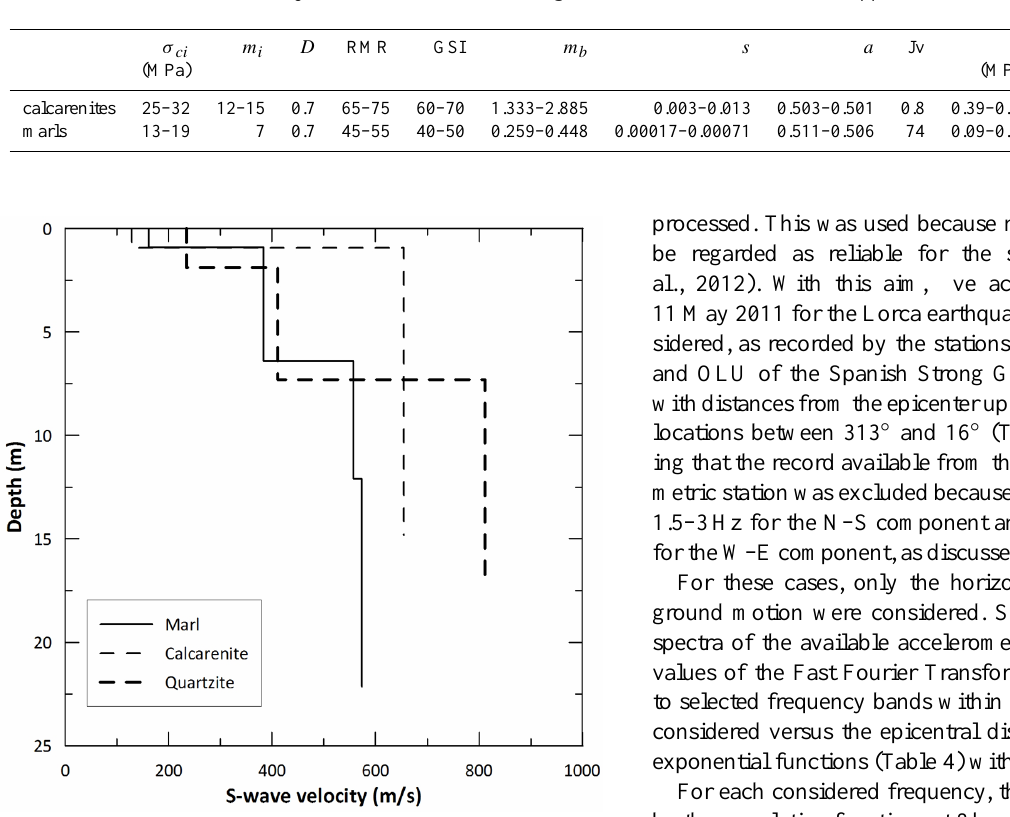
Fig. 4. 1-D S-wave profiles obtained for marly, calcarenitic and